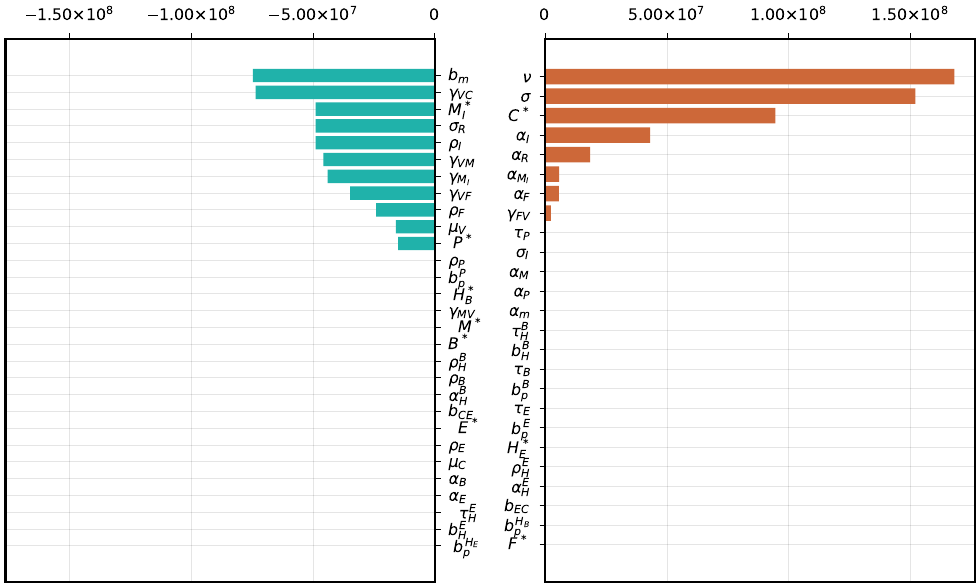
Figure 4. Local parameter variation. Normalized sensitivity indices for viral load peak Φ ( p ) = 5.9 × 10 7 peak